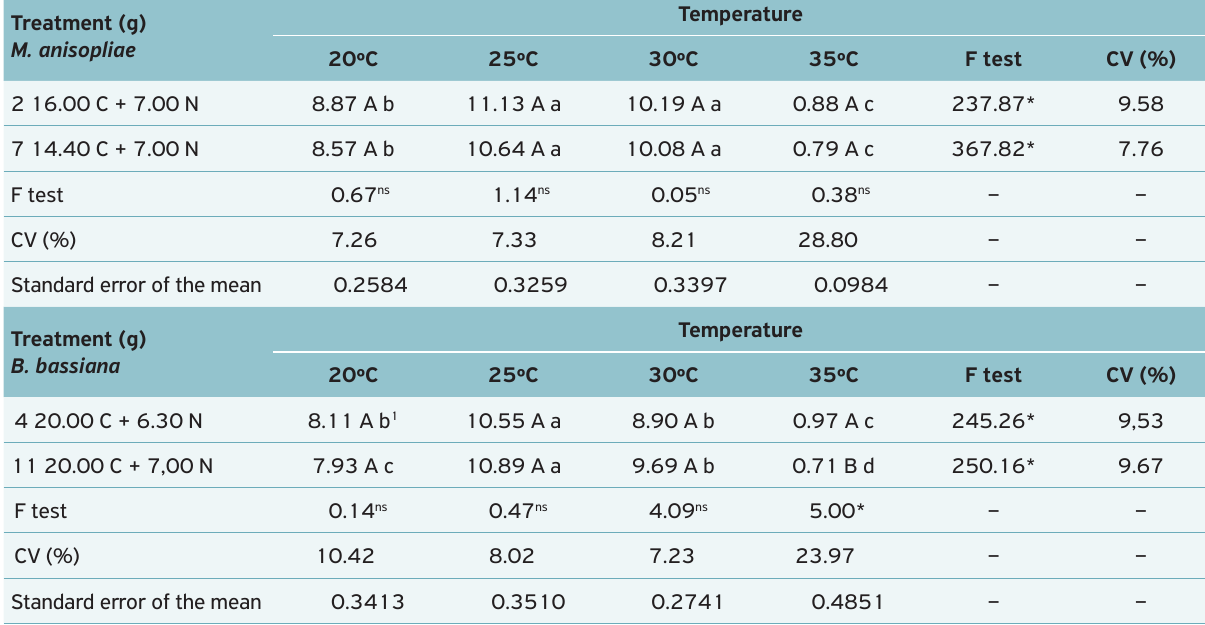
Table 6. Number of colonies of Metarhizium anisopliae (IBCB 425) and Beauveria bassiana (IBCB 66) obtained after inoculation of blastospores produced in liquid media and exposed to different